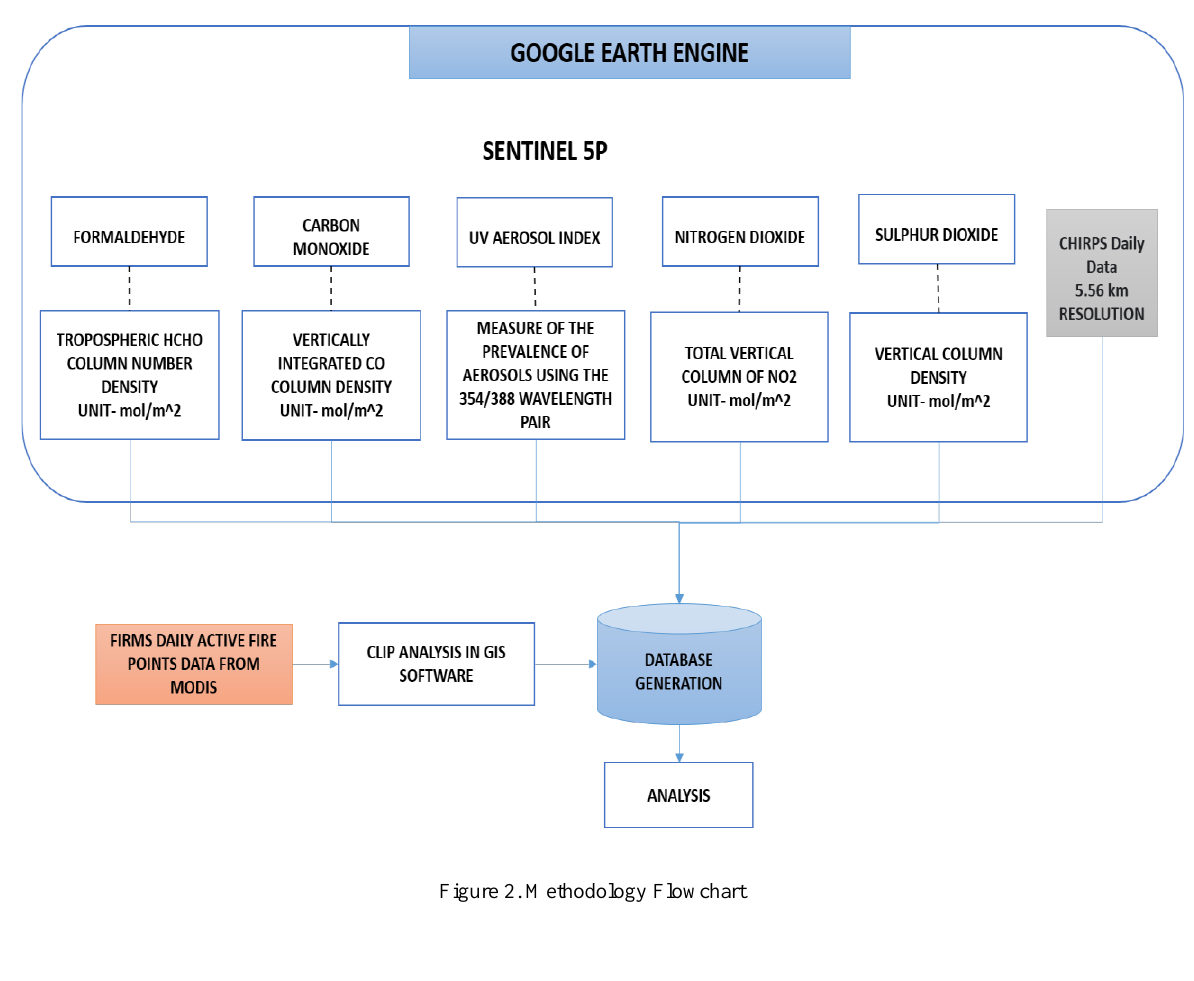
Figure 2. Methodology